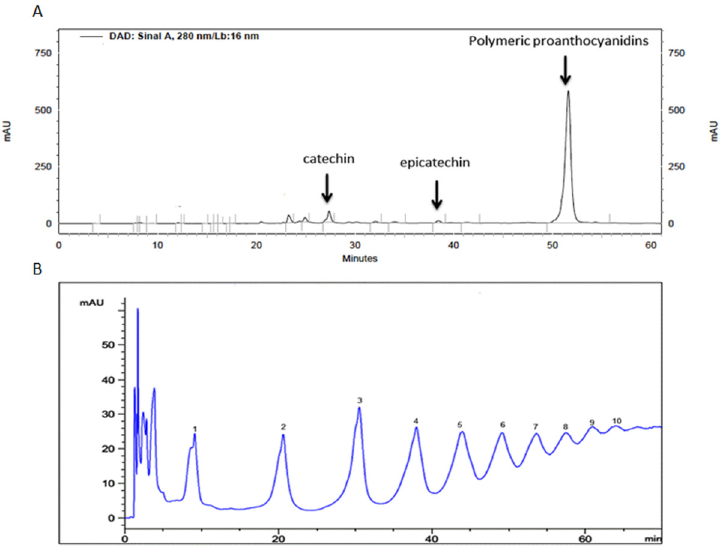
Fig 1. HPLC analysis of ASE. (A) HPLC analysis of the aqueous residue of ASE according to Peng, et al (2001) [21]. The marked peaks of 27, 38 and 51 min correspond to catechin, epicatechin and oligomeric and polymeric condensed tannins. (B) HPLC analysis of the aqueous fraction residue according to Kelm, et al (2006) [23], where the marked peaks (1 to 10) shows the series of condensed tannins present in the sample from monomer to decamer.